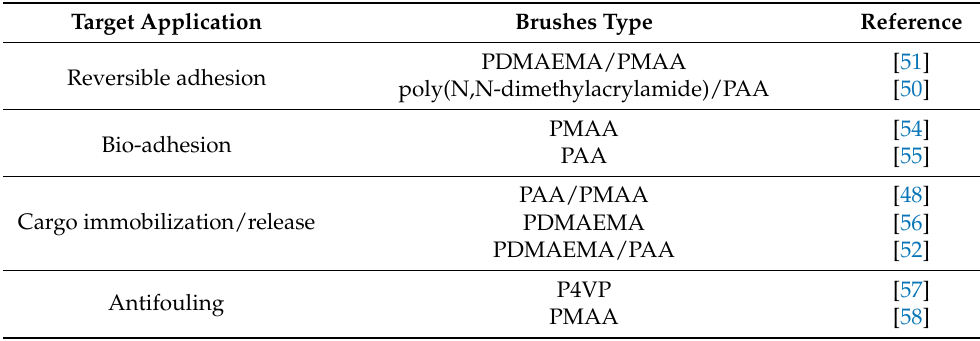
Table 2. Typical brushes based on weak polyelectrolytes and emerging applications.